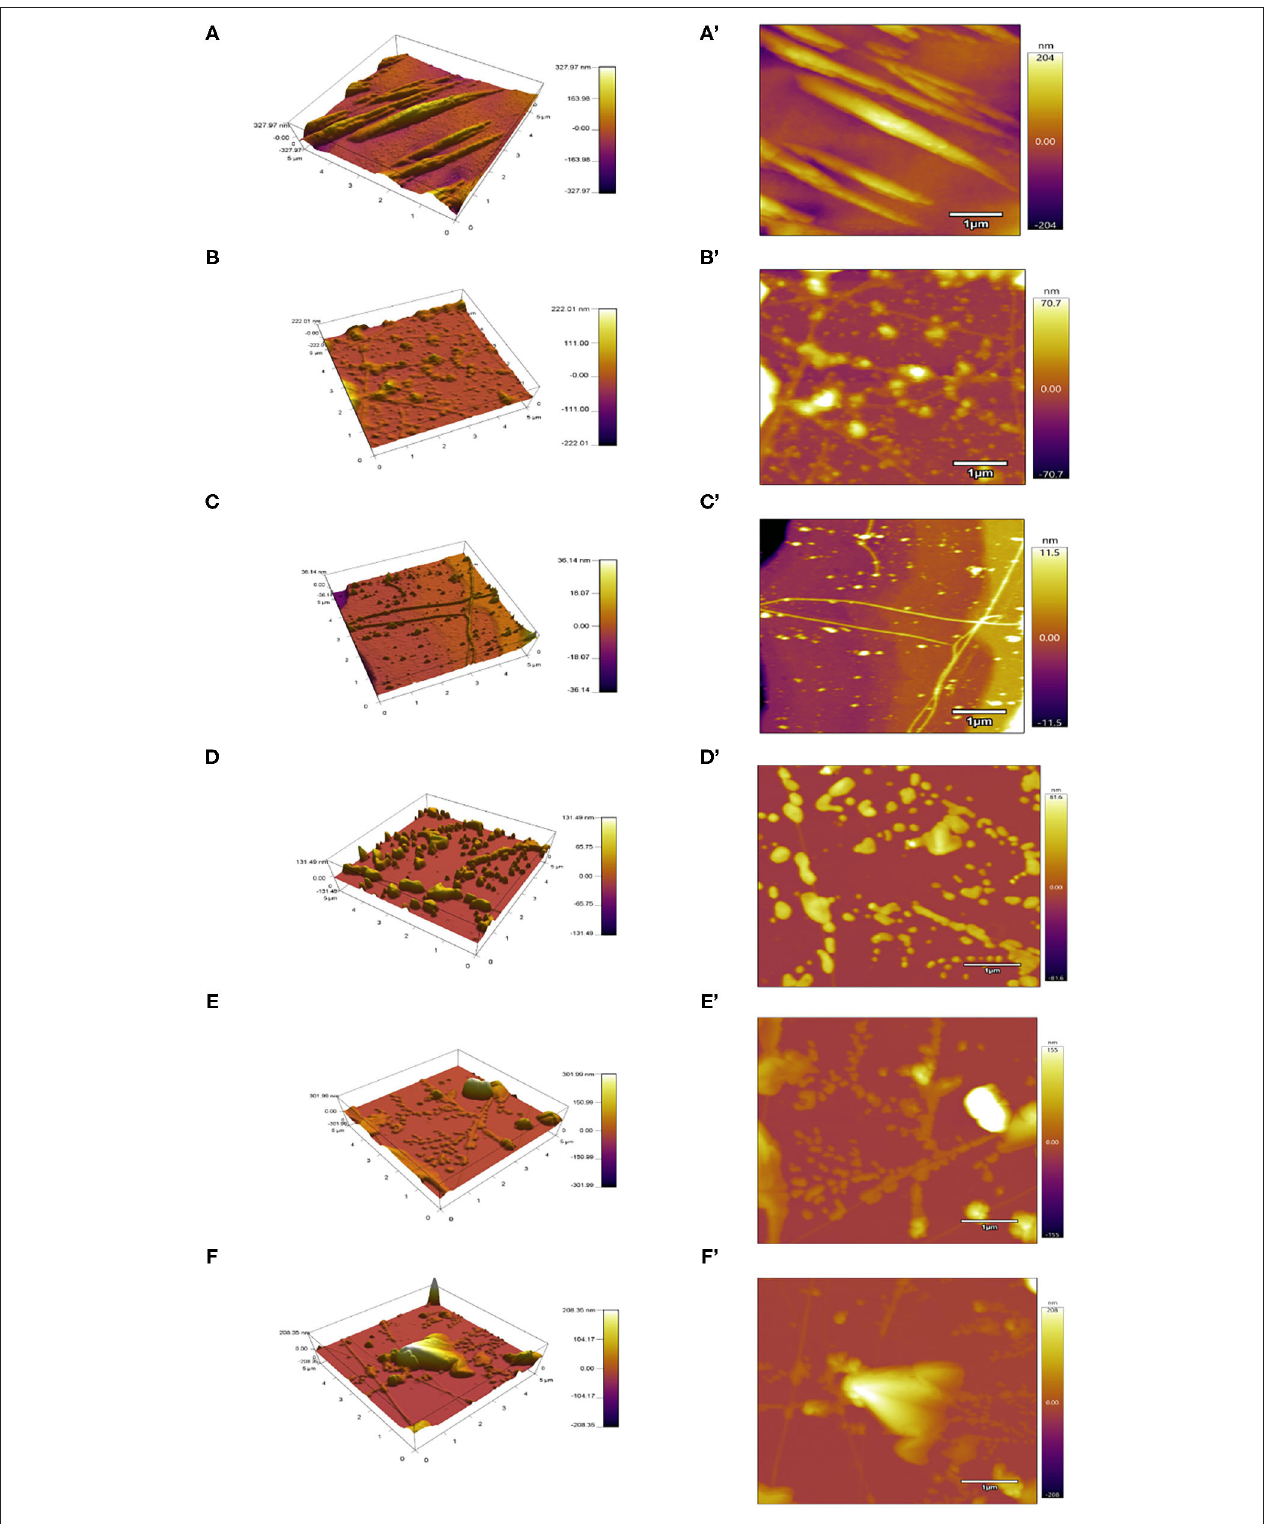
FIGURE 4 | Atomic force microscopy (AFM) images of different UHP treated MP solutions from the scallop mantle. 3D view (A–F) and top view (A’–F’) .